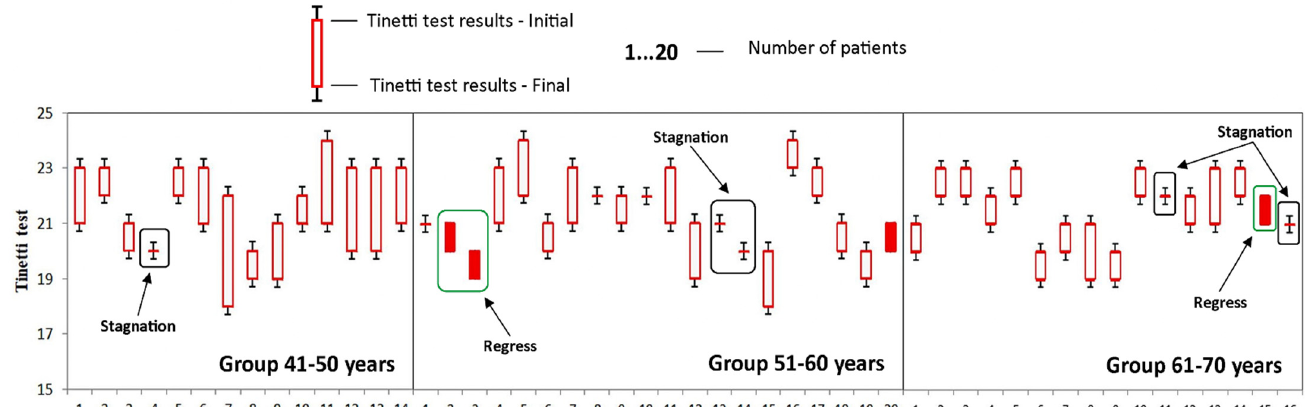
Figure 5. Evolution of hip flexion during the study at the group A. Stagnation—the value of the parameter obtained at time T1 is the same as the value of the parameter obtained at time T0; Re- gress—the parameter obtained at time T1 is less than the value of the parameter obtained at time T0.